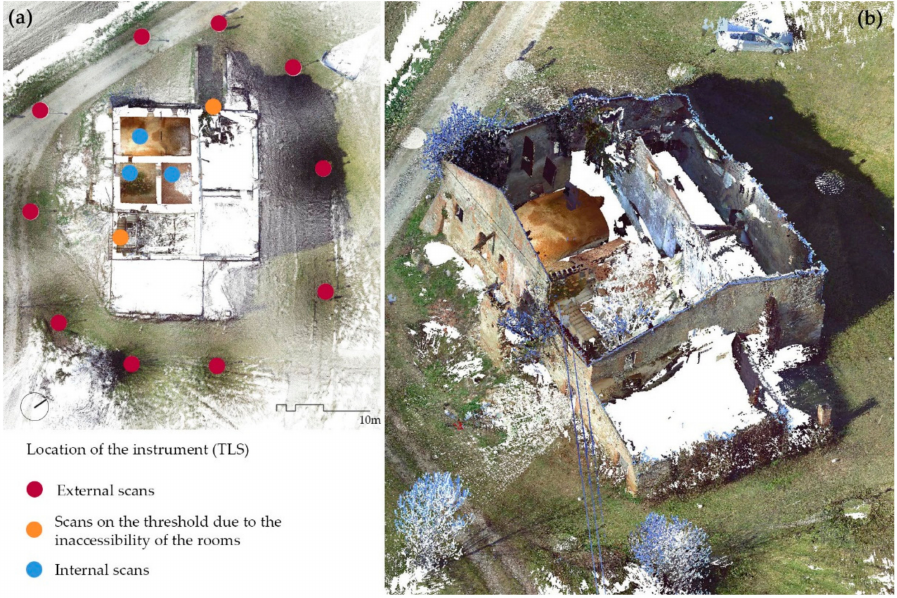
Figure 3. ( a ) Project of instrument location for massive acquisition with a laser scanner. ( b ) View of the aligned point